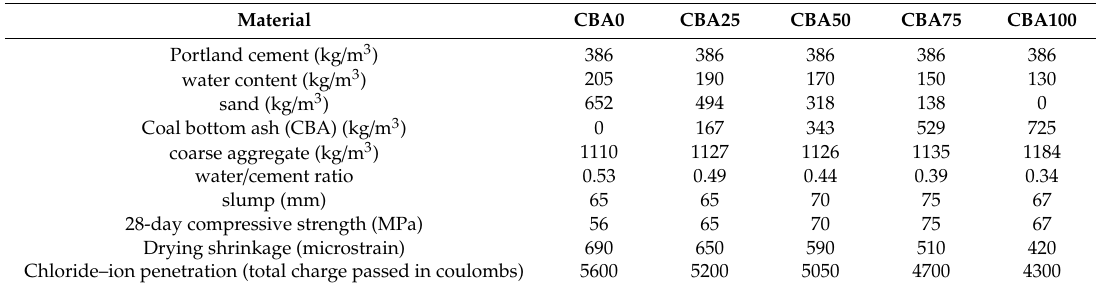
Table 1. Mixture with a fixed slump range (MIX-fixed-SLUMP): Concrete mixture design with a fixed slump range of 60–80 mm and the concrete’s properties (based on [15]).